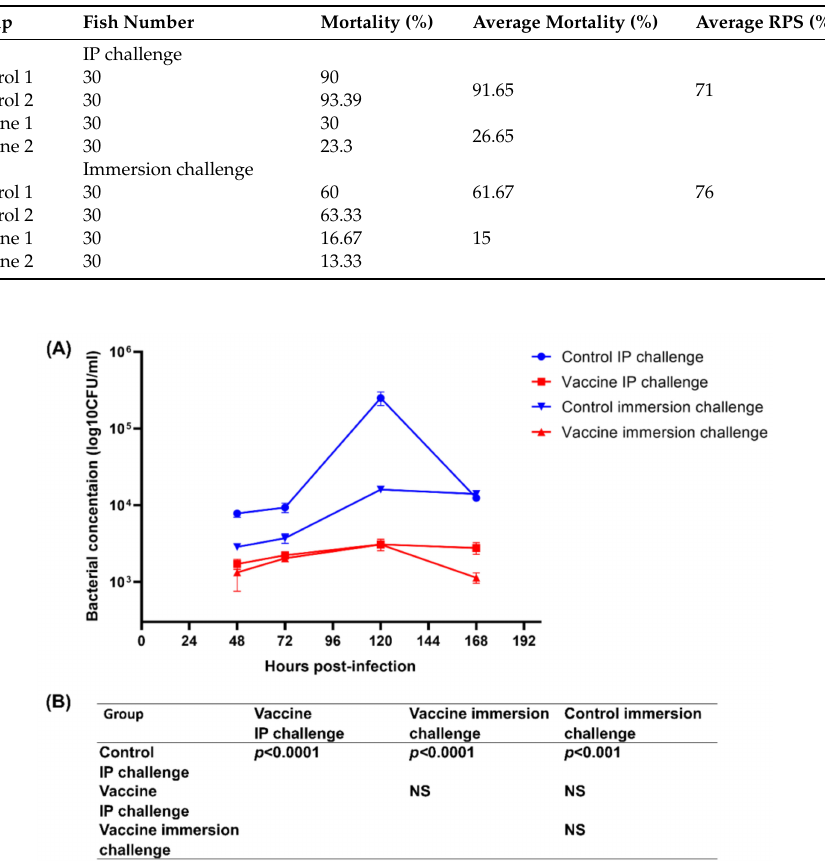
Figure 3. The averages of the cumulative mortalities of tilapia challenged with the Fno vaccine strain via the intraperitoneal (IP) injection method ( A ) and immersion method ( B ) at 6 weeks post primary immunization. Table 2. The cumulative mortality and relative percent survival (RPS) value in vaccinated fish and the control group at 21 days and 60 days after challenge by the IP and immersion challenge methods, respectively.